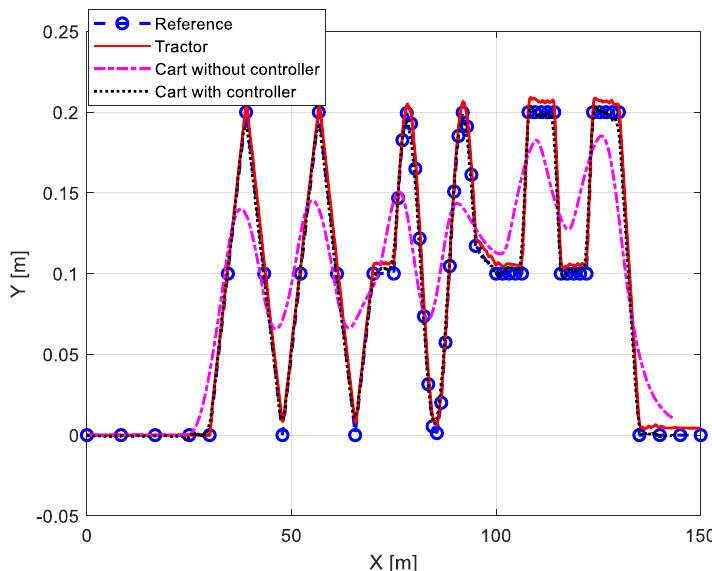
Figure 14 . Performance of tractor-cart position control system under a Mixed pattern in 2 [m/s] .